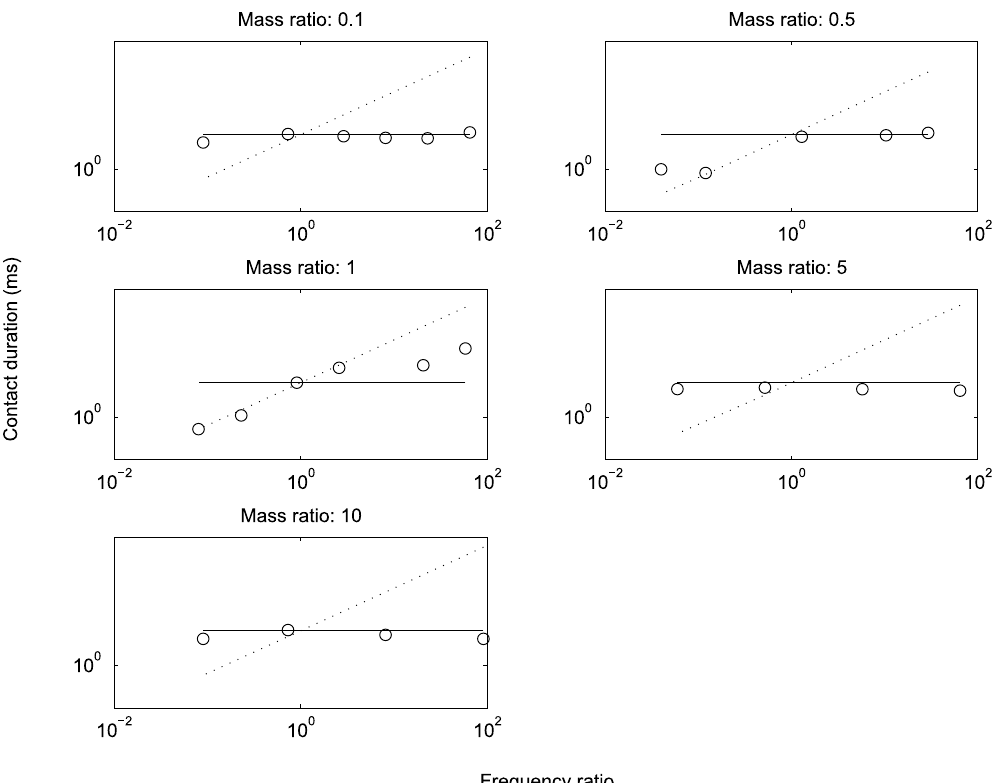
◦ ”: fi rst impact duration; solid line: 1 / 2 T AO PF ; doted line: 1 / 2 T AO FF